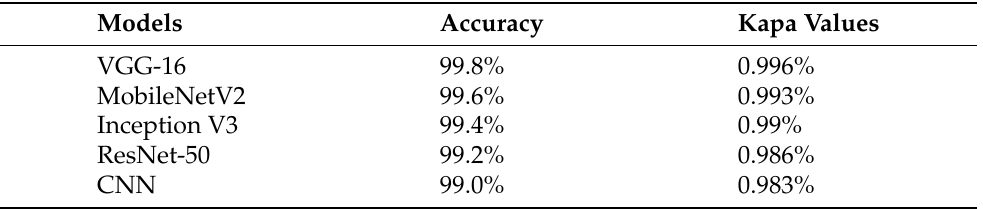
Table 3. Comparative results of models.